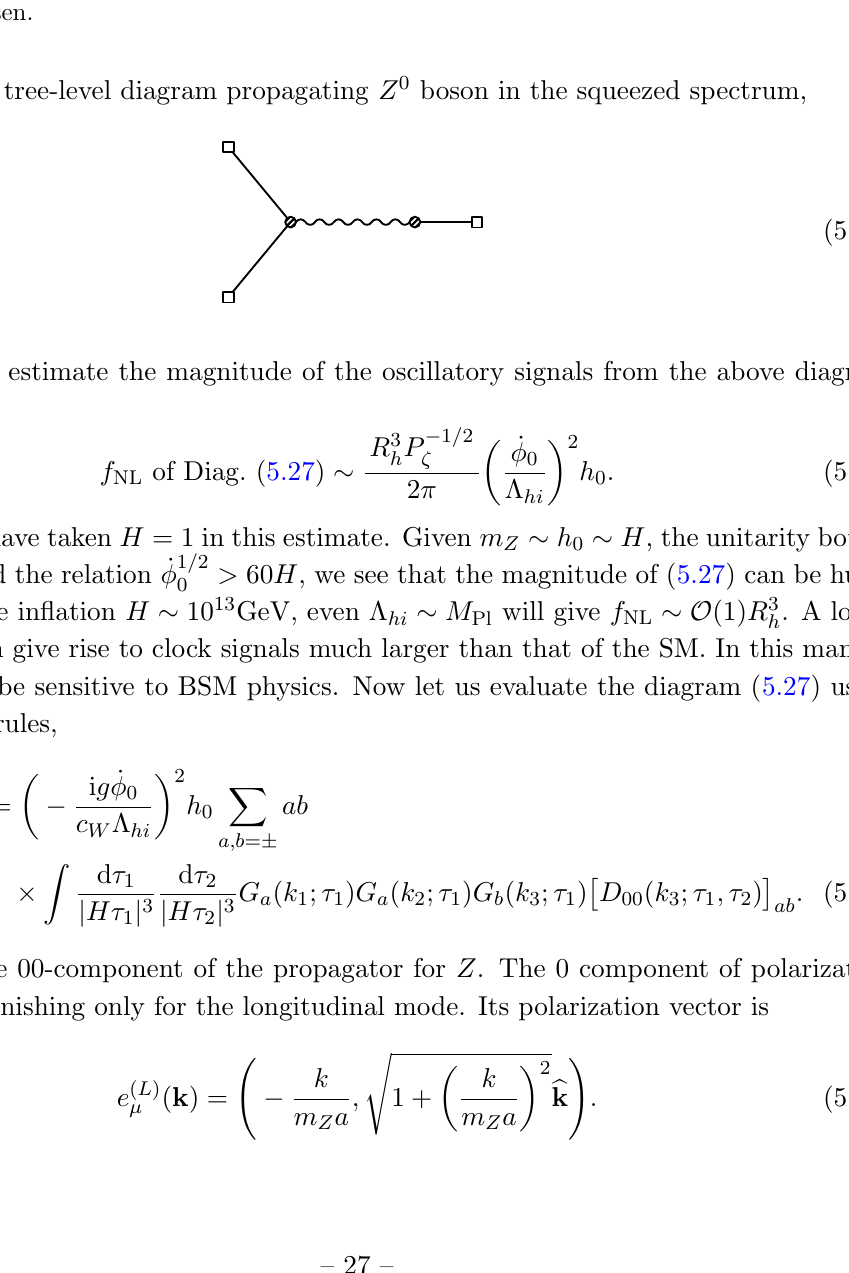
Figure 4 . SM signals at CHC. The blue, purple, and black curves show the signals strength f NL,clock as functions of particles’ mass for W , Z , and top quark, respectively. The choice of parameters are R h = 0 : 14, (cid:21) = 0 : 01, g = 0 : 6, y t = 1 and c W = 0 : 88. Even larger non-Gaussianities are possible if smaller (cid:21) is